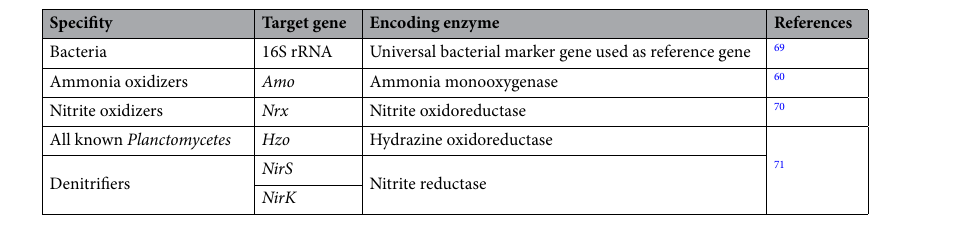
Table 1. Functional genes used in the qPCR